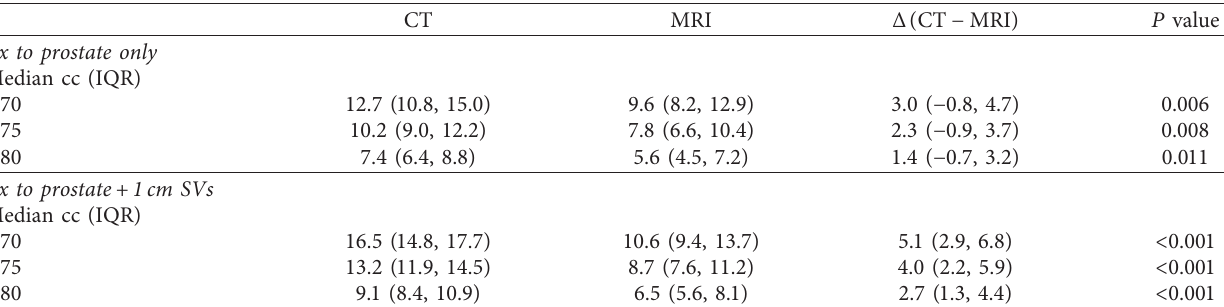
Table 2: Bladder volume exposed to high dose